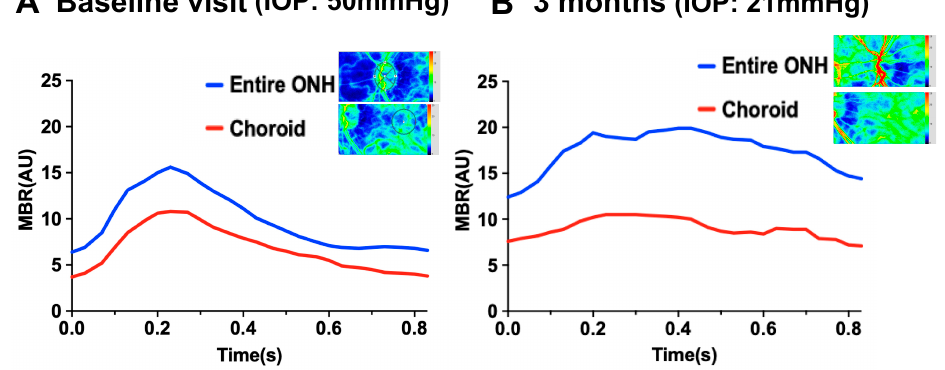
Figure 5. Changes in the pulse waveform in the entire optic nerve head and the choroid at baseline and 3 months after treatment. Pulse waveform in the entire optic nerve head (ONH) and the choroid at baseline. Intraocular pressure (IOP) was 50mmHg ( A ). Pulse waveform in the entire ONH and the choroid 3 months after treatment. IOP was 21mmHg ( B ). Blue color indicates the entire ONH, and red color indicates the choroid.